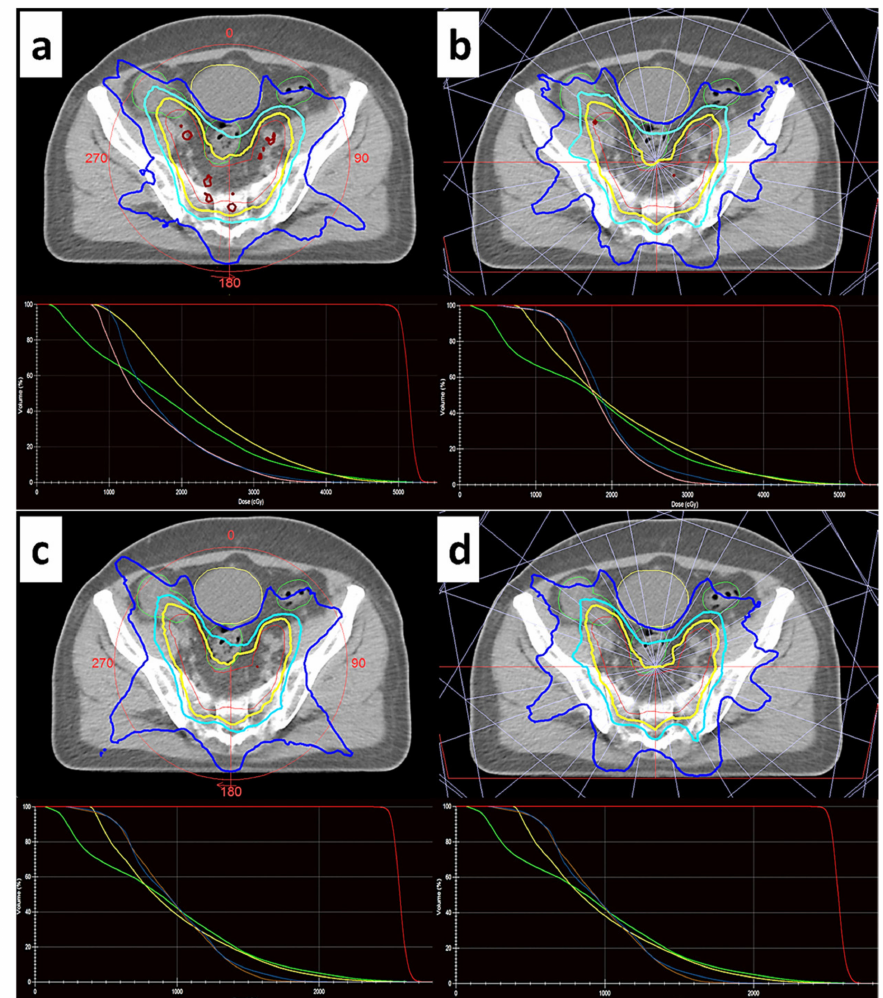
Figure 1. For an indicative patient, an axial slice of the planning CT scan is shown with isodose lines superimposed, for the ( a , b ) CFRT (25 × 2 Gy) and ( c , d ) HFRT (5 × 5 Gy) fractionation schemes. Cor- responding cumulative DVHs are given below. ( a , c ) VMAT treatment delivery technique. ( b , d ) IMRT treatment delivery technique. The photon beam energy of 10 MV is used for all plans shown. Isoline legend: dark blue: 50%; light blue: 75%; yellow: 95%. DVH and contour legend: red: PTV; yellow: bladder; green: bowel; pink: left femoral head; blue: right femoral